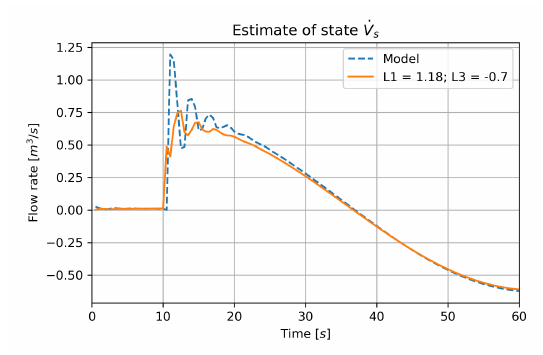
Figure 10: Observer behavior when both measurement x 1 and x 3 are injected. Measurements without noise from the more detailed hy- dropower model.